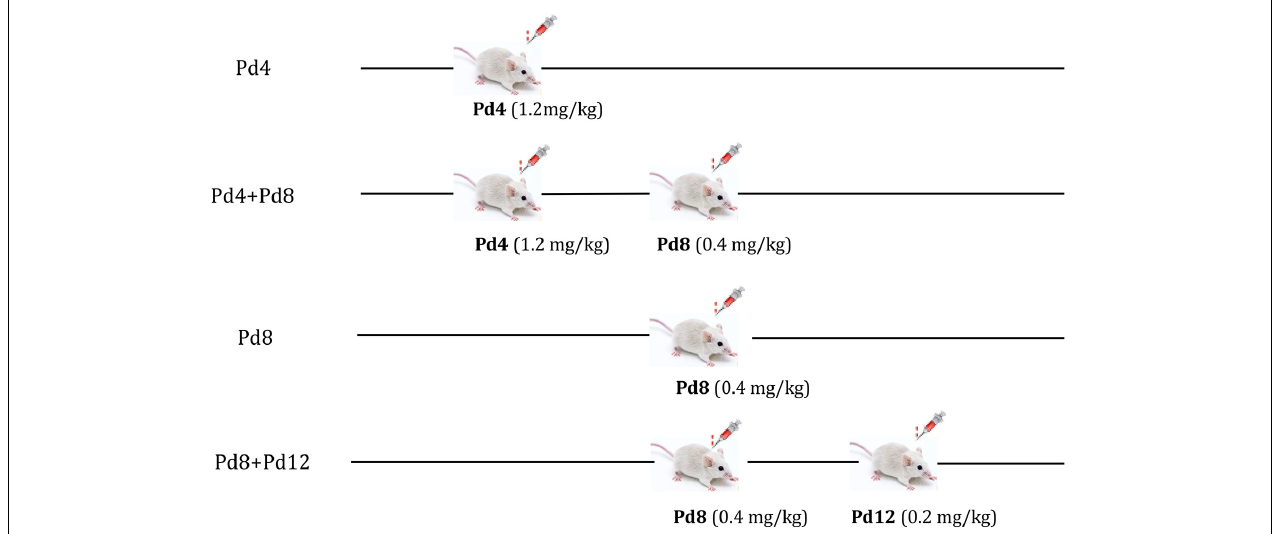
FIGURE 1 | The strategy of mifepristone administration to the pregnant mice on pregnancy day 4 (Pd4), Pd8, or Pd12. Pd4: mice were treated with 1, 3-propanediol or mifepristone on Pd4; Pd4 + Pd8: mice were treated with 1, 3-propanediol or mifepristone on Pd4 and Pd8, respectively; Pd8: mice were treated with 1, 3-propanediol or mifepristone on Pd8; Pd8 + Pd12: mice were treated with 1, 3-propanediol or mifepristone on Pd8 and Pd12, respectively.